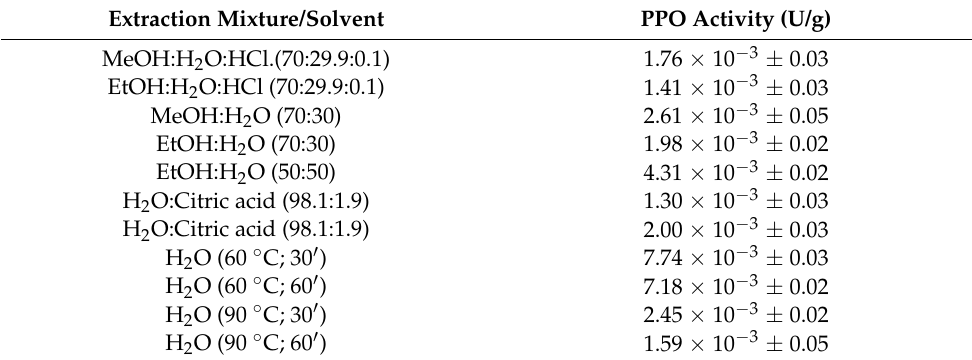
Table 3. Extraction conditions and PPO activity of the olive leaf